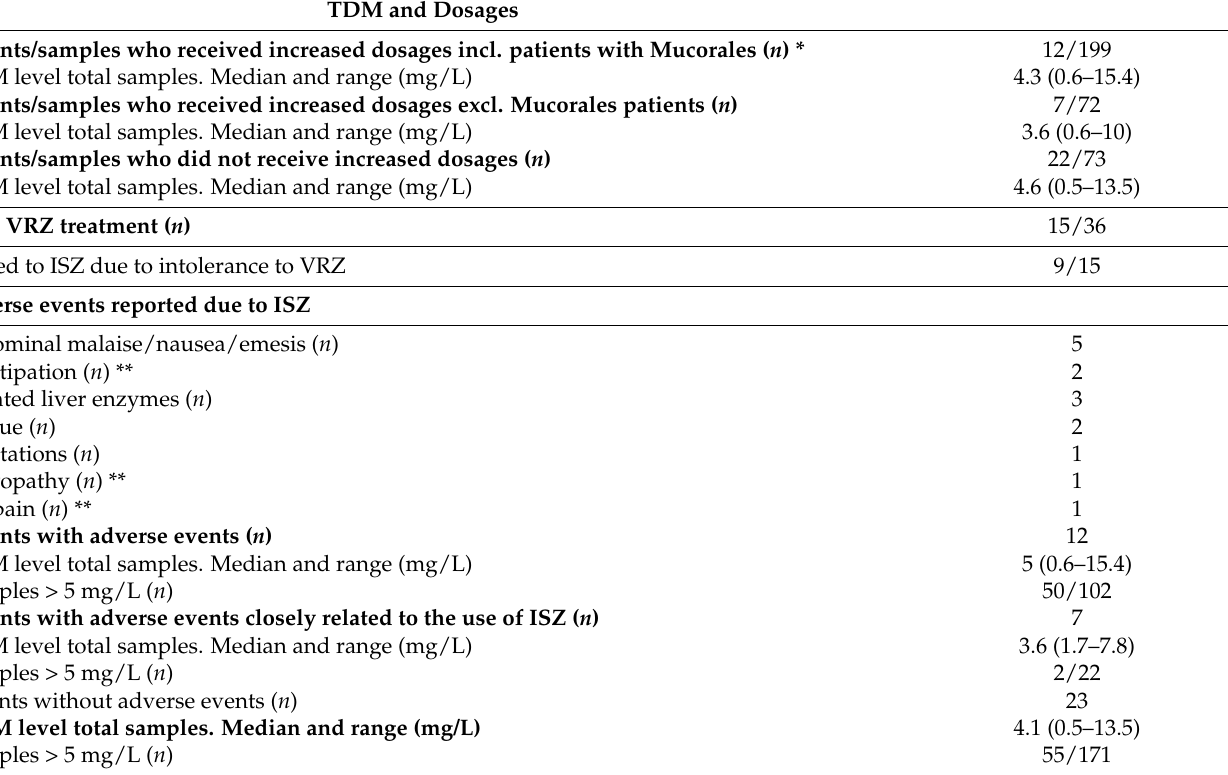
Figure 2. Serum concentration levels of 35 patients at Danish hospitals receiving ISZ with various dosages. The serum concentrations were determined by HPLC with a fluorescence detector during a period of 33 months. The age of the patients at the beginning of treatment is indicated on the x -axis and patient groups are separated by a dashed line. a: ≤ 25 years, b: 26–50 years, c: 51–75 years and d: >75 years. One patient with Aspergillus had Aspergillus flavus and was treated empirically with ISZ until species identification, then was switched to VRZ. Table 2. TDM values and tolerance data. TDM and